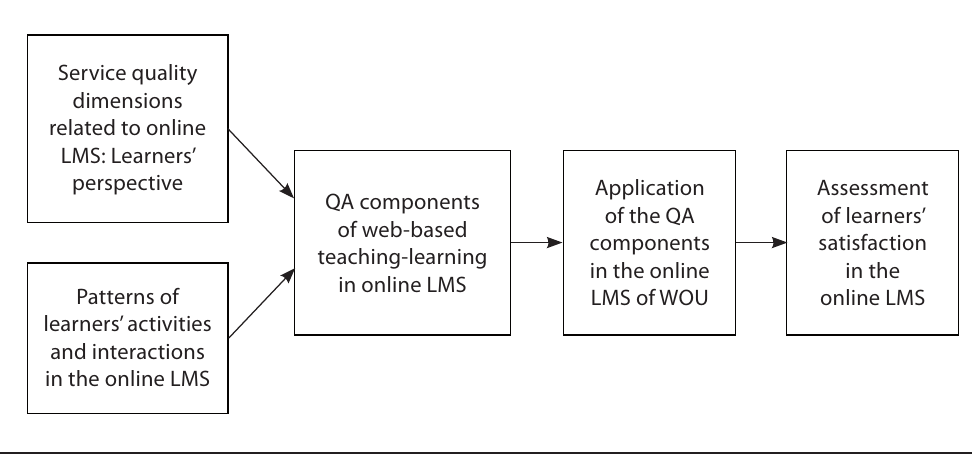
Figure 1 Conceptual framework of the case